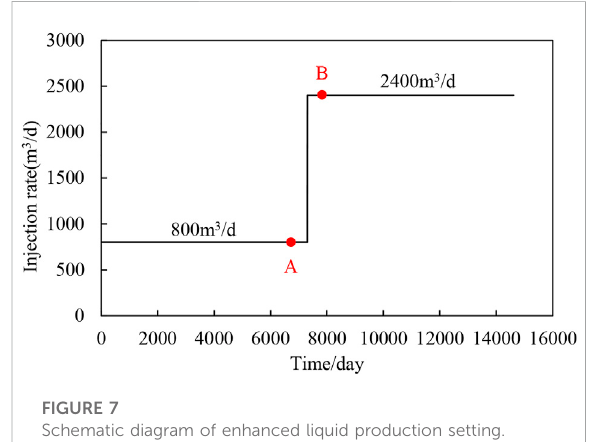
FIGURE 7 Schematic diagram of enhanced liquid production setting.